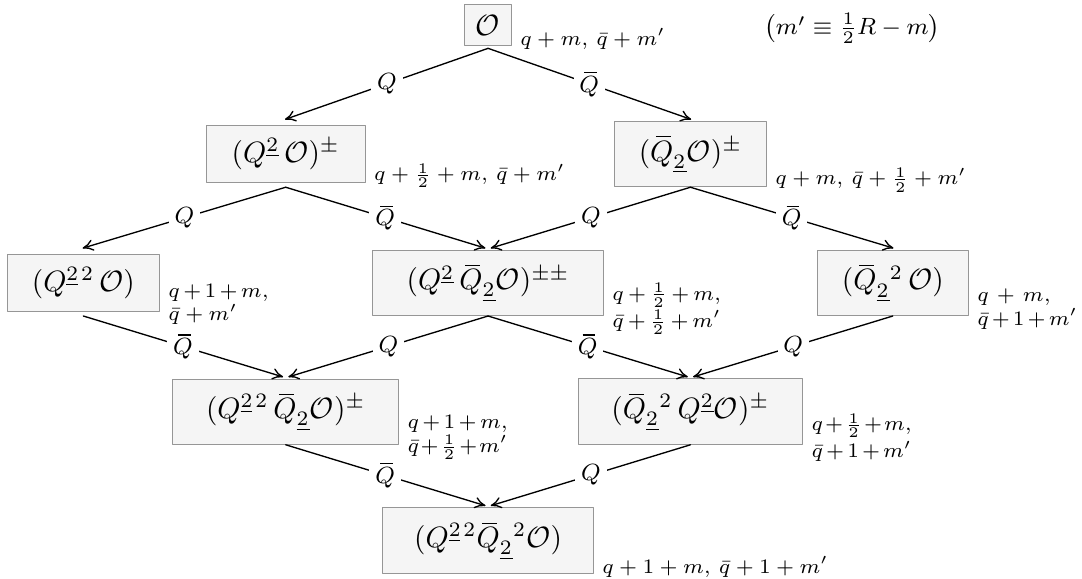
Figure 2 . Diagram of all N = 1 multiplets in an N = 2 long multiplet. Superscripts of (cid:6) indicate the choice of spin j (cid:6) 1 or (cid:22) | (cid:6) 1. Subscripts indicate the N = 1 q; (cid:22) q charges. Here m = R 3 takes integer spaced values between (cid:0) R= 2 and R= 2 and m 0 (cid:17) R= 2 (cid:0) m . The u (1) N =2 R-charge grows from left to right by 1 and the conformal dimension grows from top to bottom by 1 = 2. A box represents a family of long N = 1